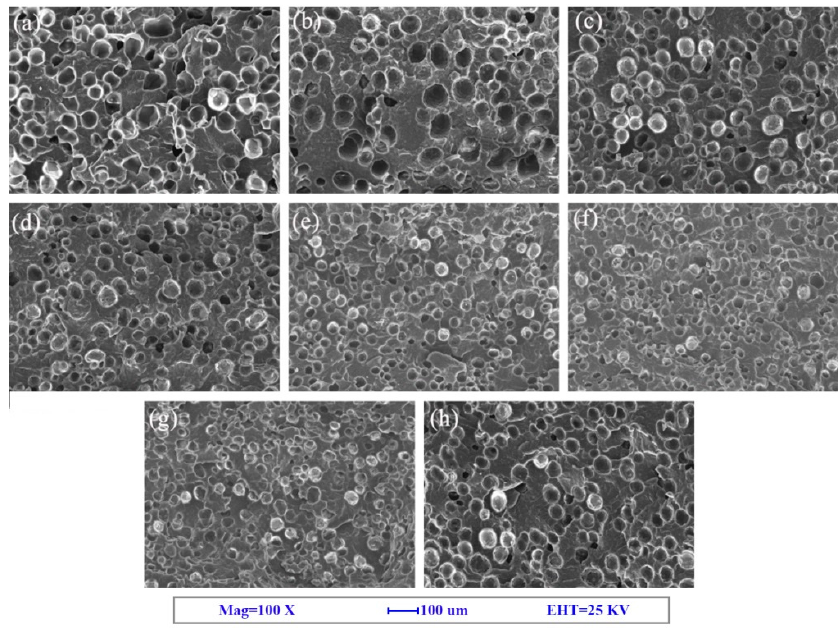
Figure 3. SEM images of the PP and PP + hemicucurbit[6]uril (HQ[6]) (PH) composite foams: ( a ) PP, ( b ) PH0.25, ( c ) PH0.5, ( d ) PH1, ( e ) PH2, ( f ) PH3, ( g ) PH5, and ( h ) PH7.